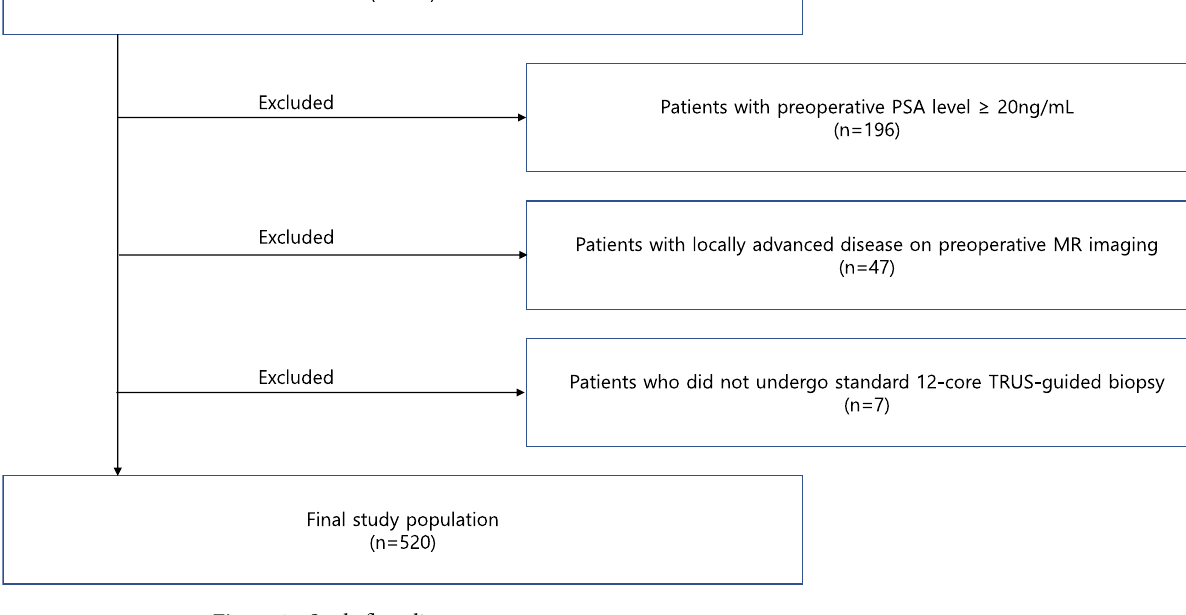
Figure 1. Study flow